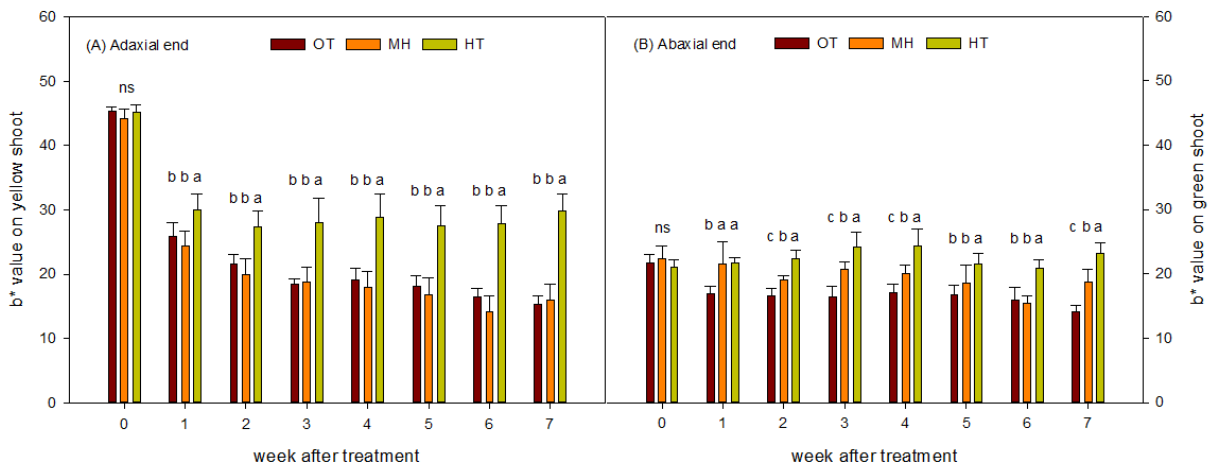
Figure 3. The color change of the shoot on the adaxial ( A ) and abaxial ends ( B ) was described as the b* value in “Da Hong” pitaya during control (OT, 30 °C/20 °C), moderately high temperature (MH, 35 °C/25 °C) and high temperature (HT, 40 °C/30 °C) treatments. ns—not significant at the 5% level. Means followed by different letters within the group bars are significantly different by the least significant difference test at p < 0.05. Each value represents the mean ± SD of five potted plants. Between one and three positions were measured in each potted plant .